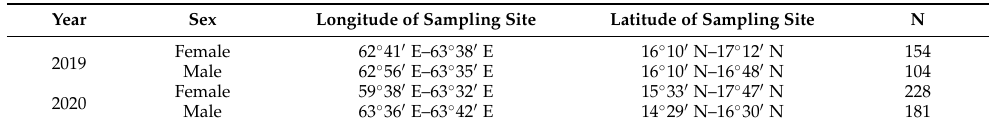
Table 1. Basic information of female and male S. oualaniensis specimens collected in different years in the northwest Indian